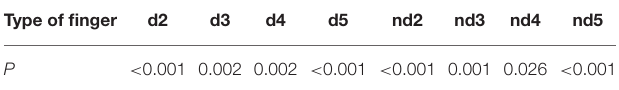
TABLE 3 | p -values for differences in the thickness of the nail plates of the corresponding types of fingers between female and male NUs. Type of